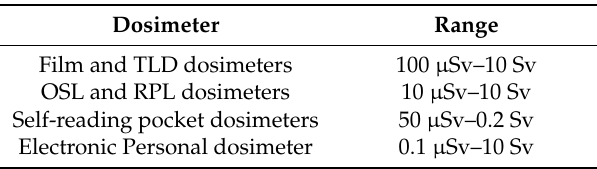
Table 3. Radiation range for personal